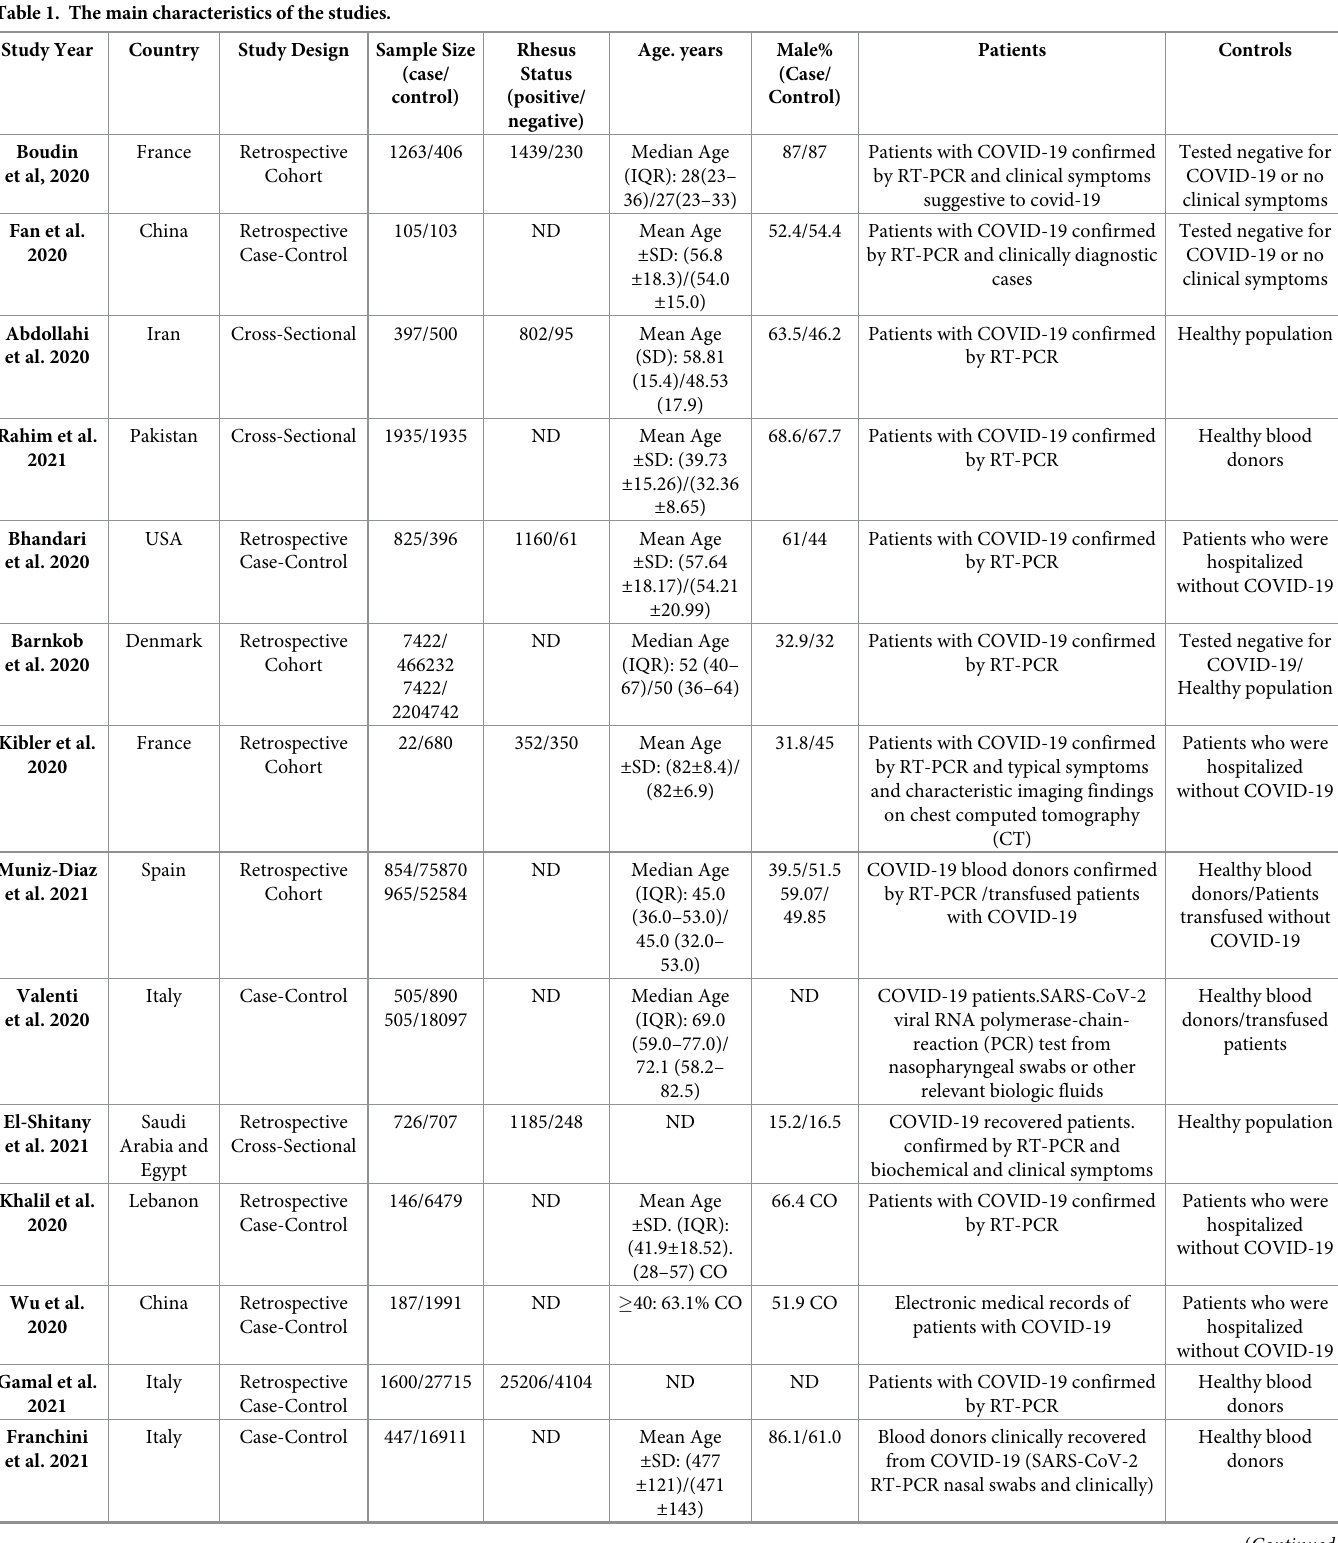
Table 1. The main characteristics of the